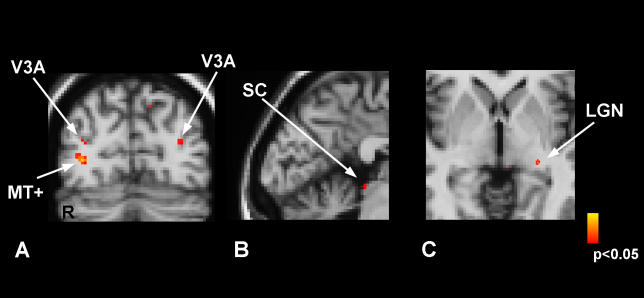
Fractional Anisotropy Differences in Migraineurs Versus Healthy ControlsCoronal (A) and sagittal (B) sections show the areas exhibiting statistically significant lower FA values in migraineurs compared to HCs. Significant differences can be seen in the WM underlying MT+ and V3A areas (A), in the superior colliculus (SC) (B), and in the left LGN (C).